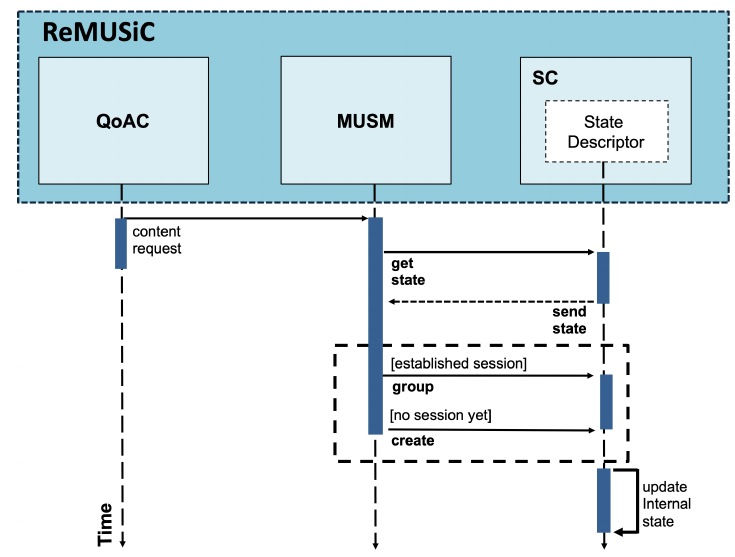
Figure 5. Sequence diagram of the procedures performed by the MultiUser Session Manager (MUSM) component.